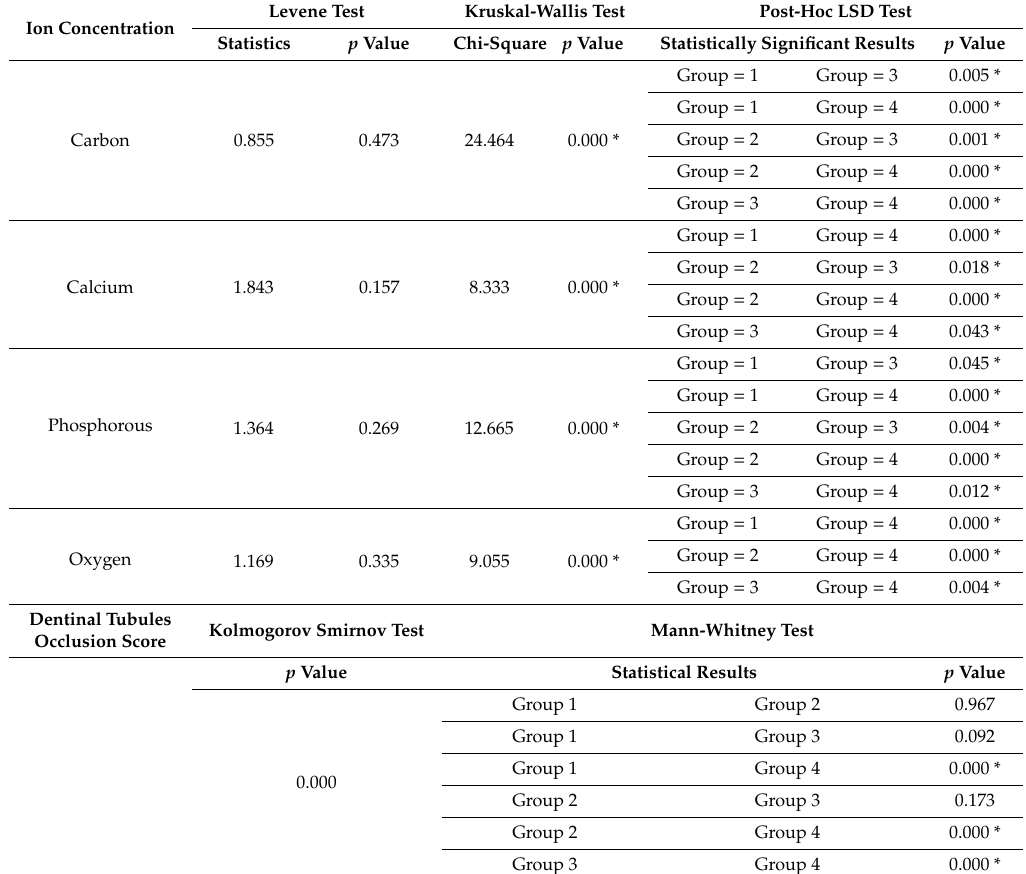
Table 4. Statistical test results when comparing the concentration of carbon, calcium, phosphorus, and oxygen ion concentration and the dentinal tubule occlusion score in